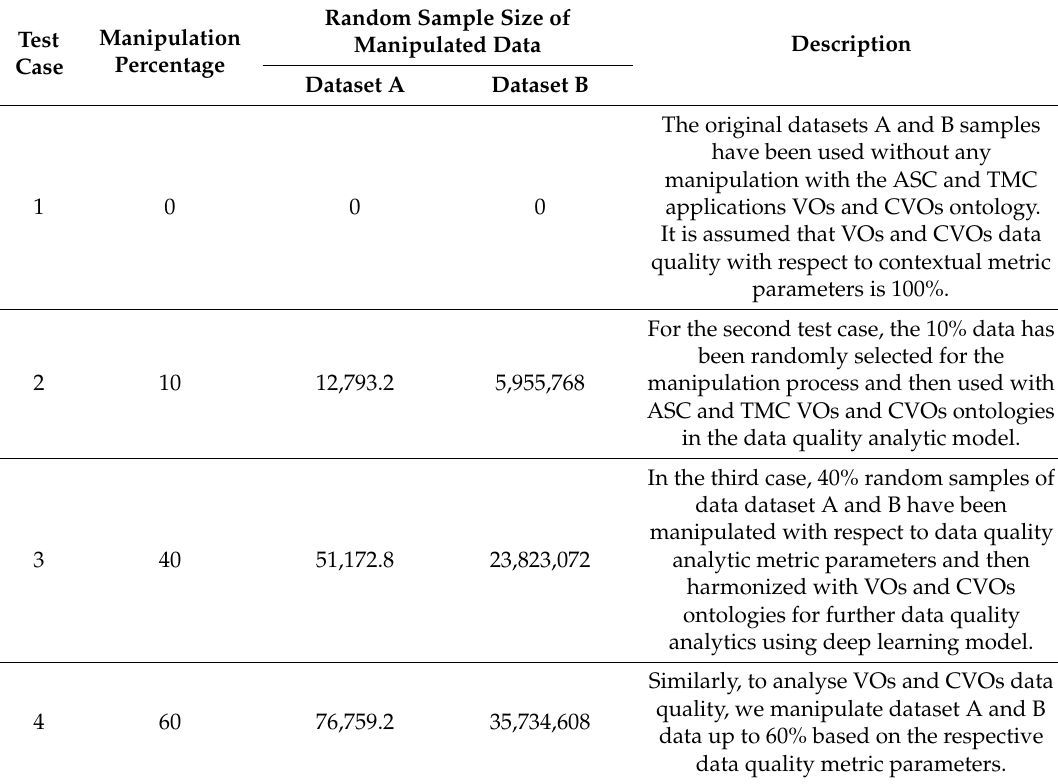
Table 1. Experimental test cases datasets